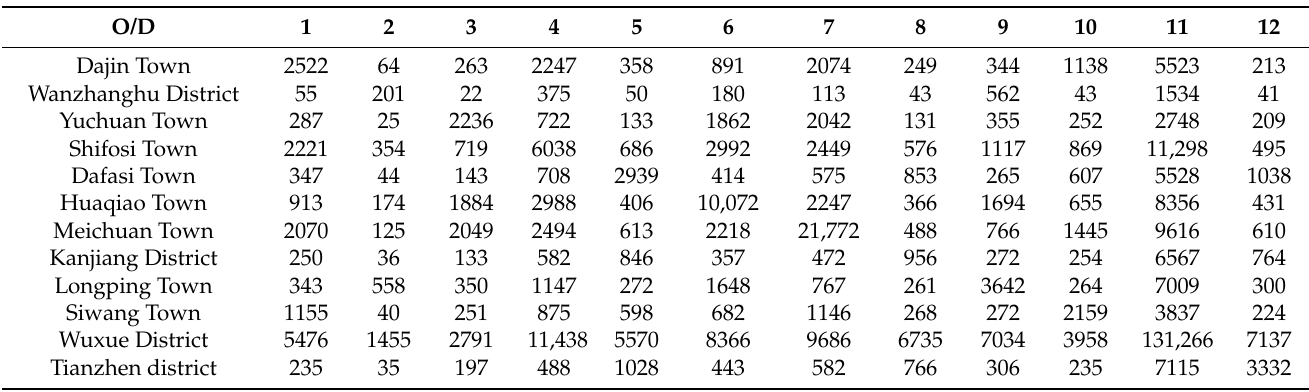
Table 2. Statistics of trips between towns.